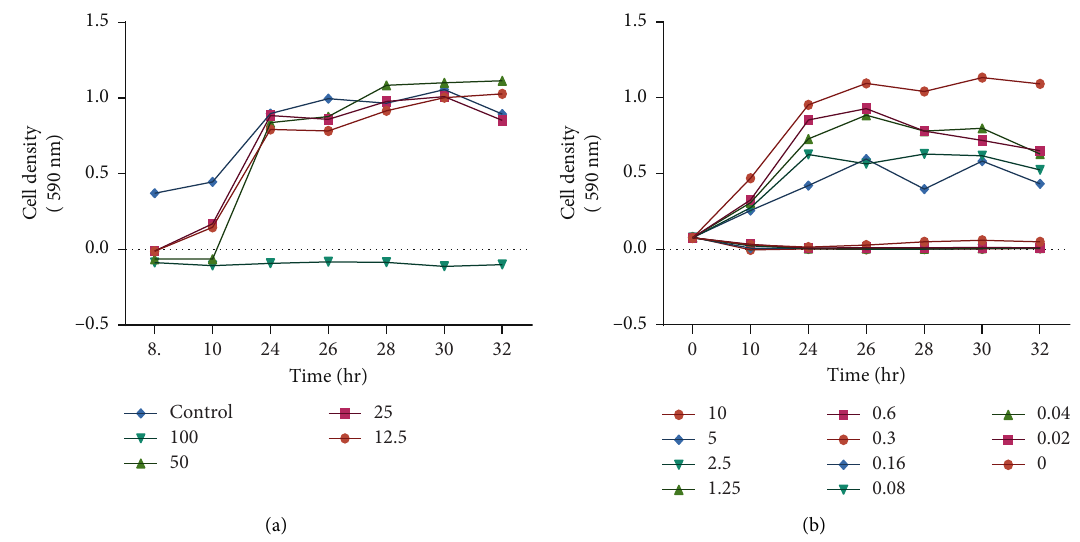
Figure 2: Time-kill curves of P aeruginosa cells after exposure to tormentic acid congener (a) and ciprofloxacin (b). Cells were standardised to 1 × 106cfu/ml. They were incubated with the compounds at 2-fold increasing concentrations for 32 hours and incubated at 37 °